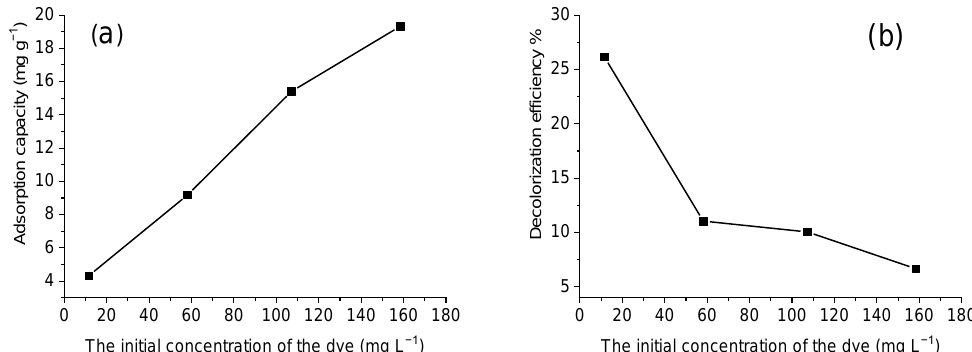
Figure 5. The effect of dye concentration on: ( a ) adsorption capacity and ( b ) discoloration of the solution.